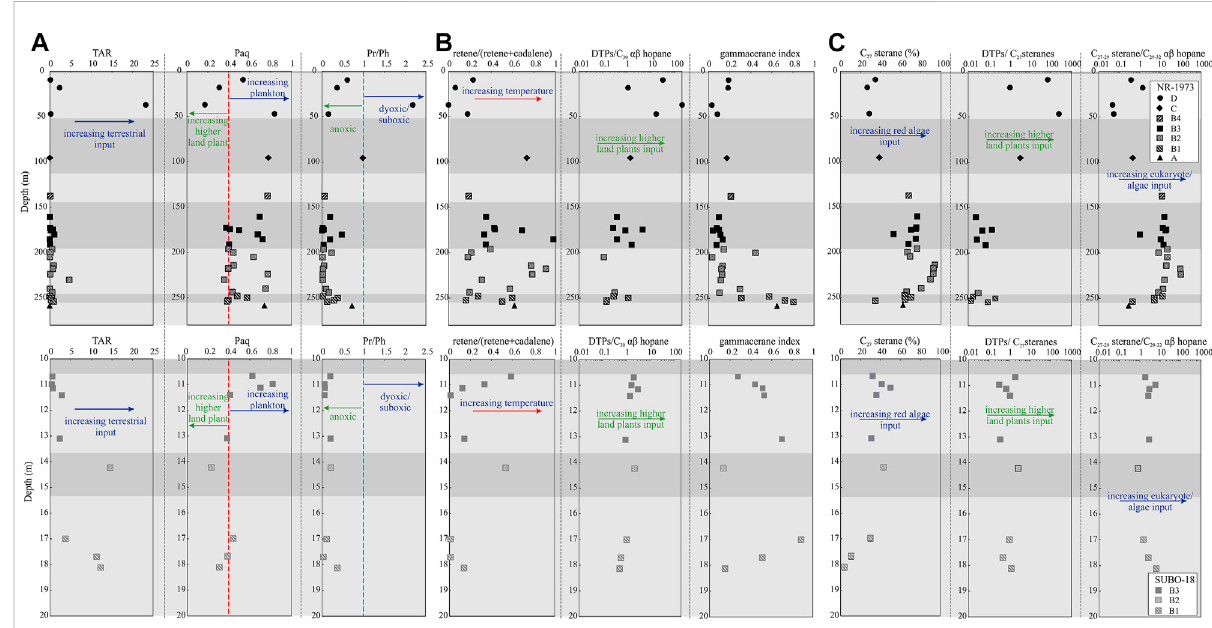
FIGURE 6 Molecular geochemical pro fi les of (A) n -alkanes and isoprenoids related proxies, (B) terpenoids and polycyclic aromatic hydrocarbons related proxies and (C) steranes related proxies for the post-impact sediments in the Nördlinger Ries. TAR = ( n- C 27 + n- C 29 + n- C 31 )/( n- C 15 + n- C 17 + n- C 19 ), Paq = ( n- C 23 + n- C 25 )/( n- C 23 + n- C 25 + n- C 29 + n- C 31 ), Pr = pristane, Ph = phytane, DTPs = diterpenes, gammacerane index = gammacerane/ (gammacerane+C 30 αβ hopane). See Figure 2 for stratigraphic